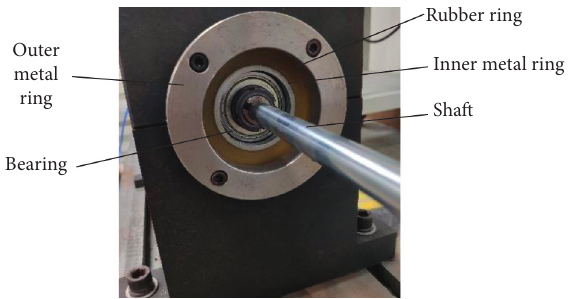
Figure 11: Shaft damping ring mounted on the